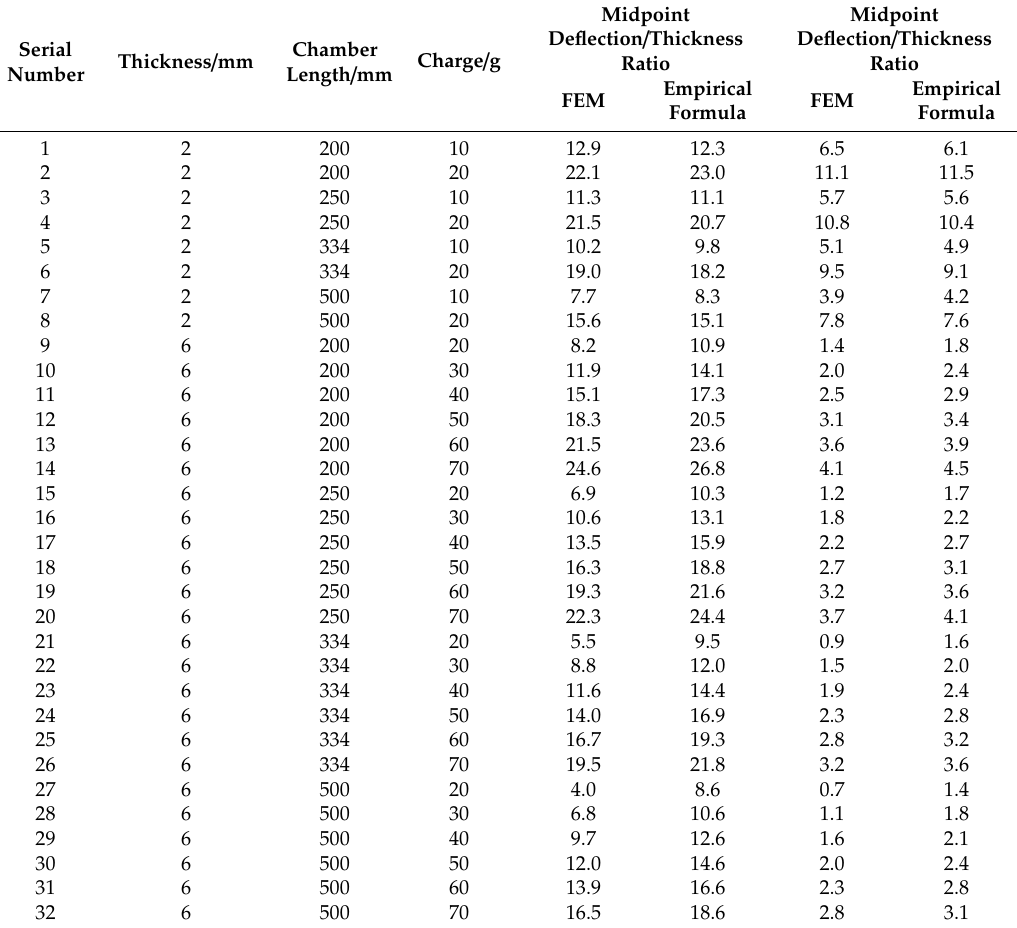
Table 4. Predicted and numerical results for the midpoint deflections of the 2 mm and 6 mm target